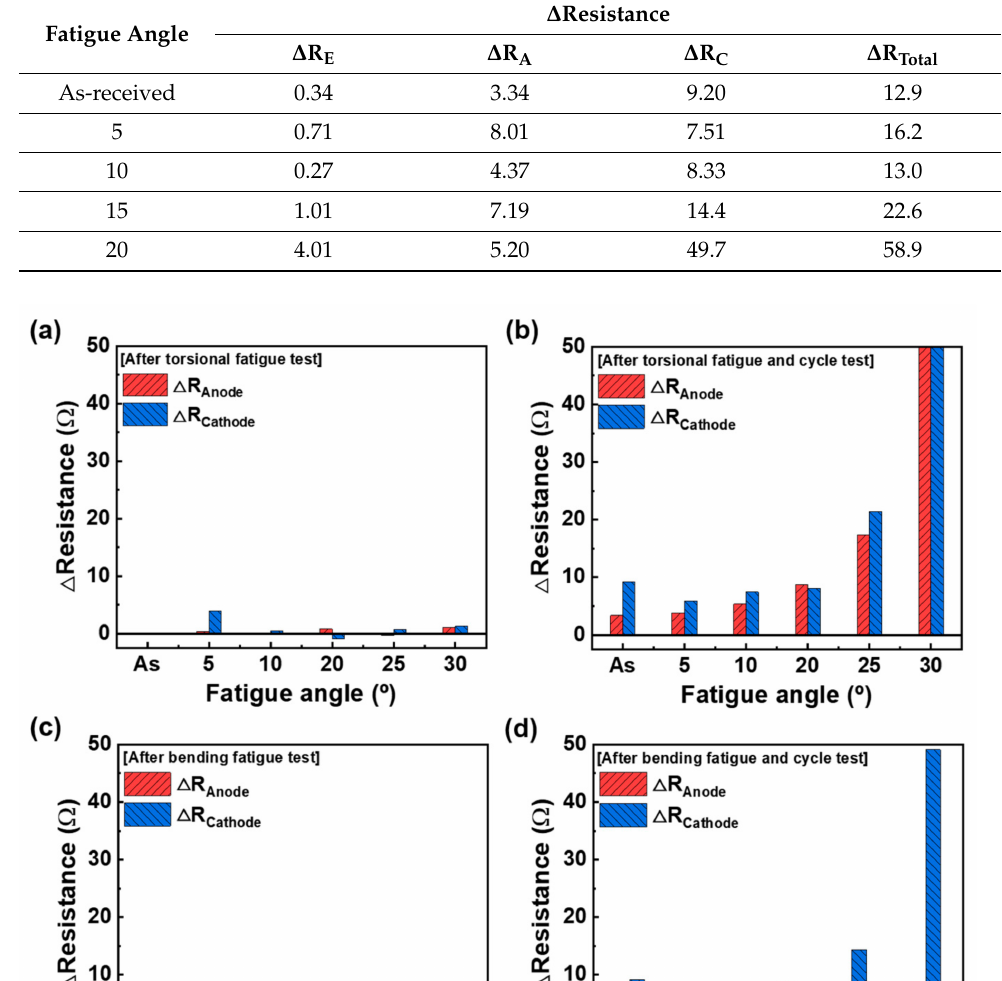
Table 4. Change values of the electrolyte resistance ( ∆ R E ), anode resistance ( ∆ R A ), and cathode resistance ( ∆ R C ) after the mechanical and cycling tests under different bending test angles.